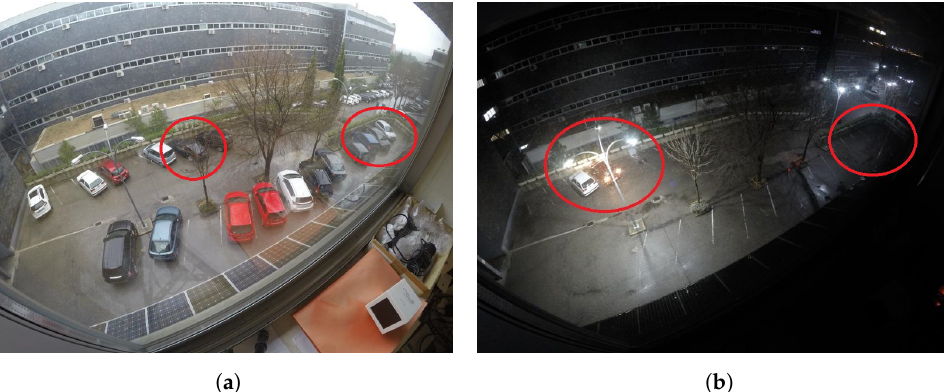
Figure 1. Examples of challenging scenarios given by illumination changes, background occlusions, inter-vehicle occlusions, and effects of the camera perspective (such as lens distortion). ( a ) Example of background occlusion and lens distortion; ( b ) example of illumination